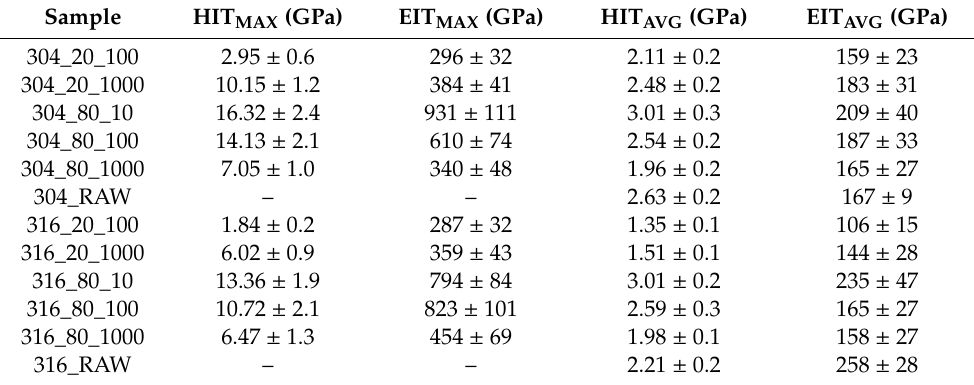
Figure 8. The scatter of nanoindentation hardness H IT versus indentation depth of: ( a ) AISI 304; and ( b ) AISI 316 laser-treated stainless steel samples. Table 4. The maximum nanoindentaion hardness H IT , maximum elastic modulus E IT and average H IT and E IT obtained for the indentation depth range of 1000–2500